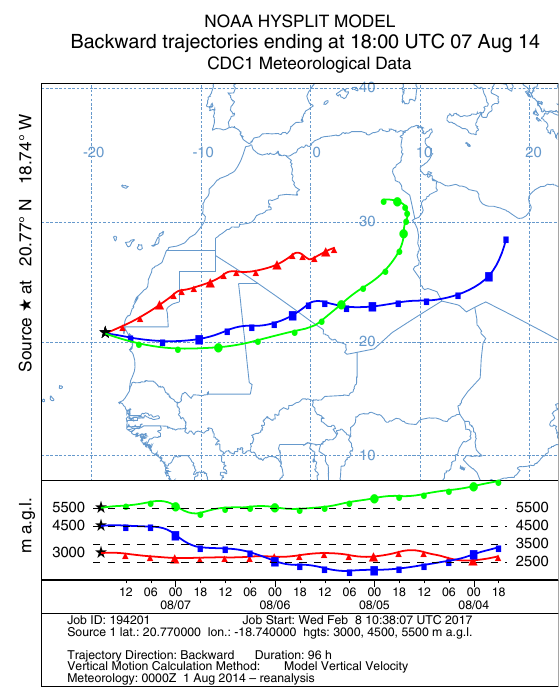
Figure A5. Four-day back trajectories at a height of 3000, 4500 and 5500m on 2 July 2013.